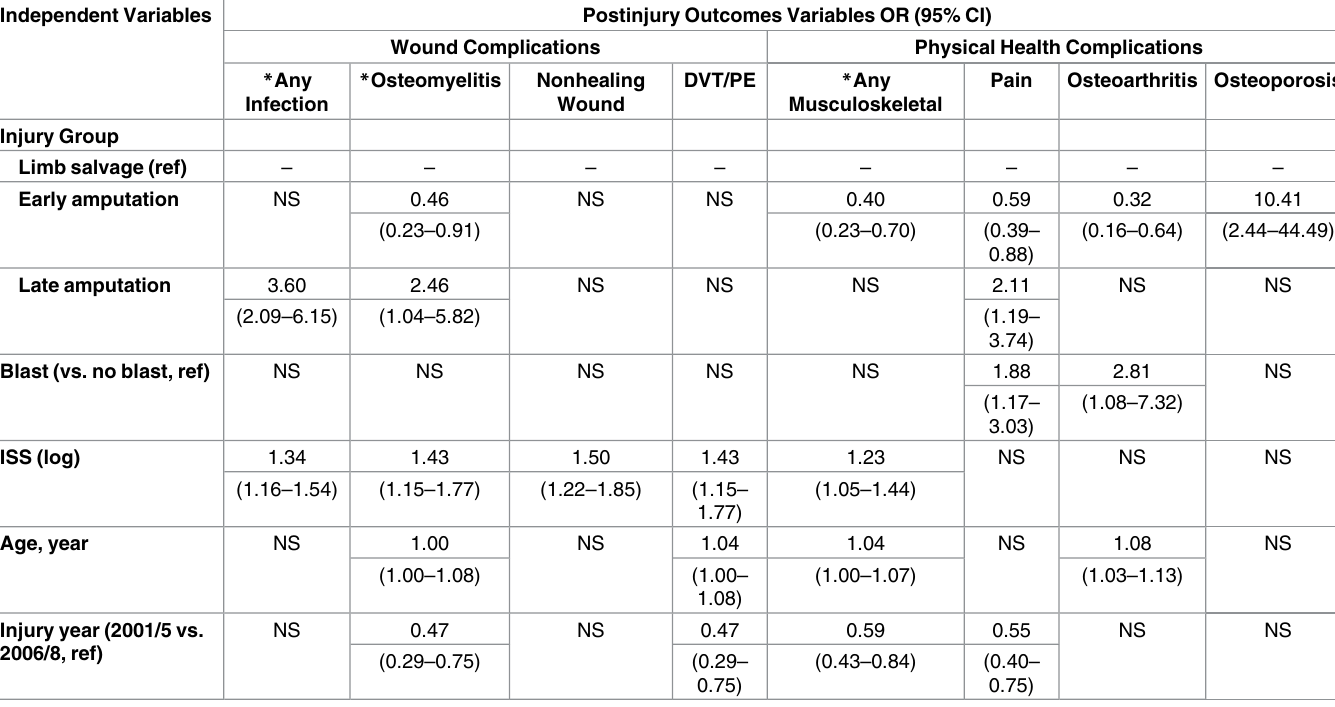
Table 3. SummaryResults for Overall (4 Year) Regression Models for Wound and Other Physical Health Complications. Independent